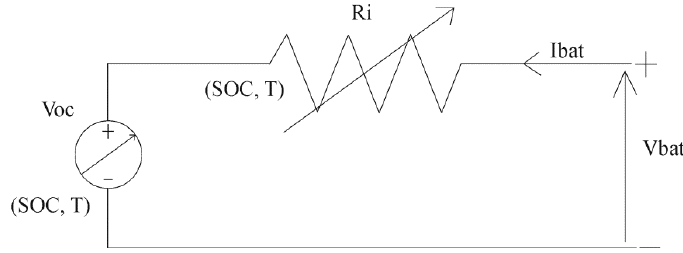
Figure 2. Equivalent circuit battery model.